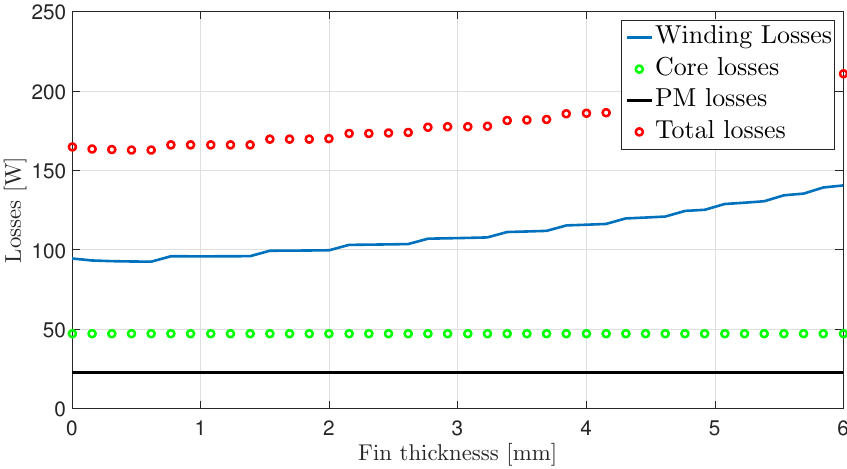
Figure 18. The losses variation with the fins